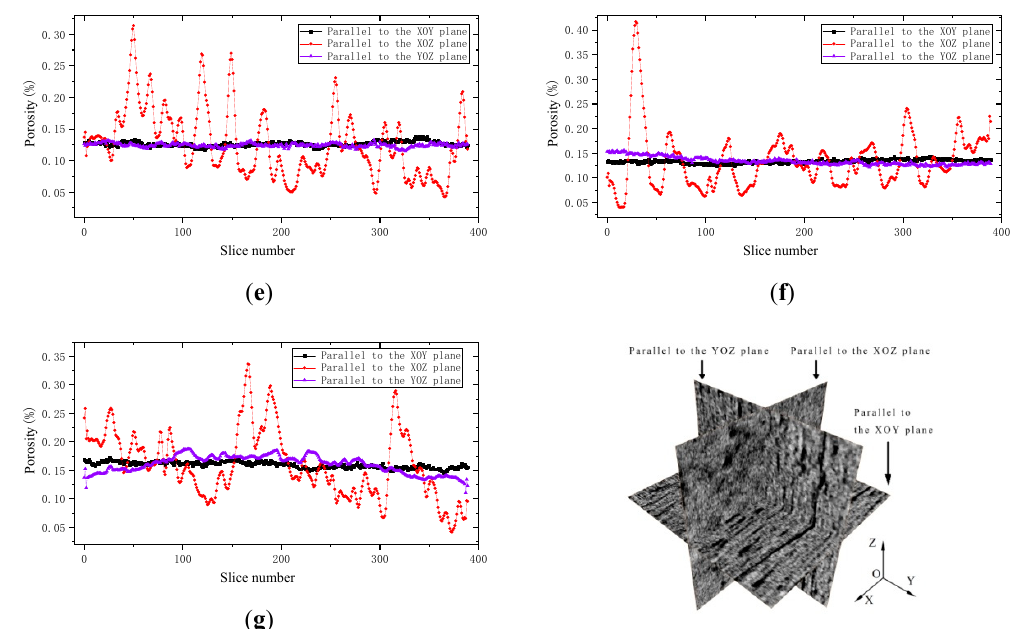
Figure 11. Change curves of porosity of CT slices parallel to the xoy, xoz, and yoz planes in the DCOSs after the pyrolysis with superheated steam at different temperatures: ( a ) 25 °C, average porosity: 2.08%; ( b ) 314 °C, average porosity: 5.60%; ( c ) 382 °C, average porosity: 8.40%; ( d ) 452 °C, average porosity: 10.37%; ( e ) 511 °C, average porosity: 14.05%; ( f ) 534 °C, average porosity: 15.25%; ( g ) 555 °C, average porosity: 16.01%.